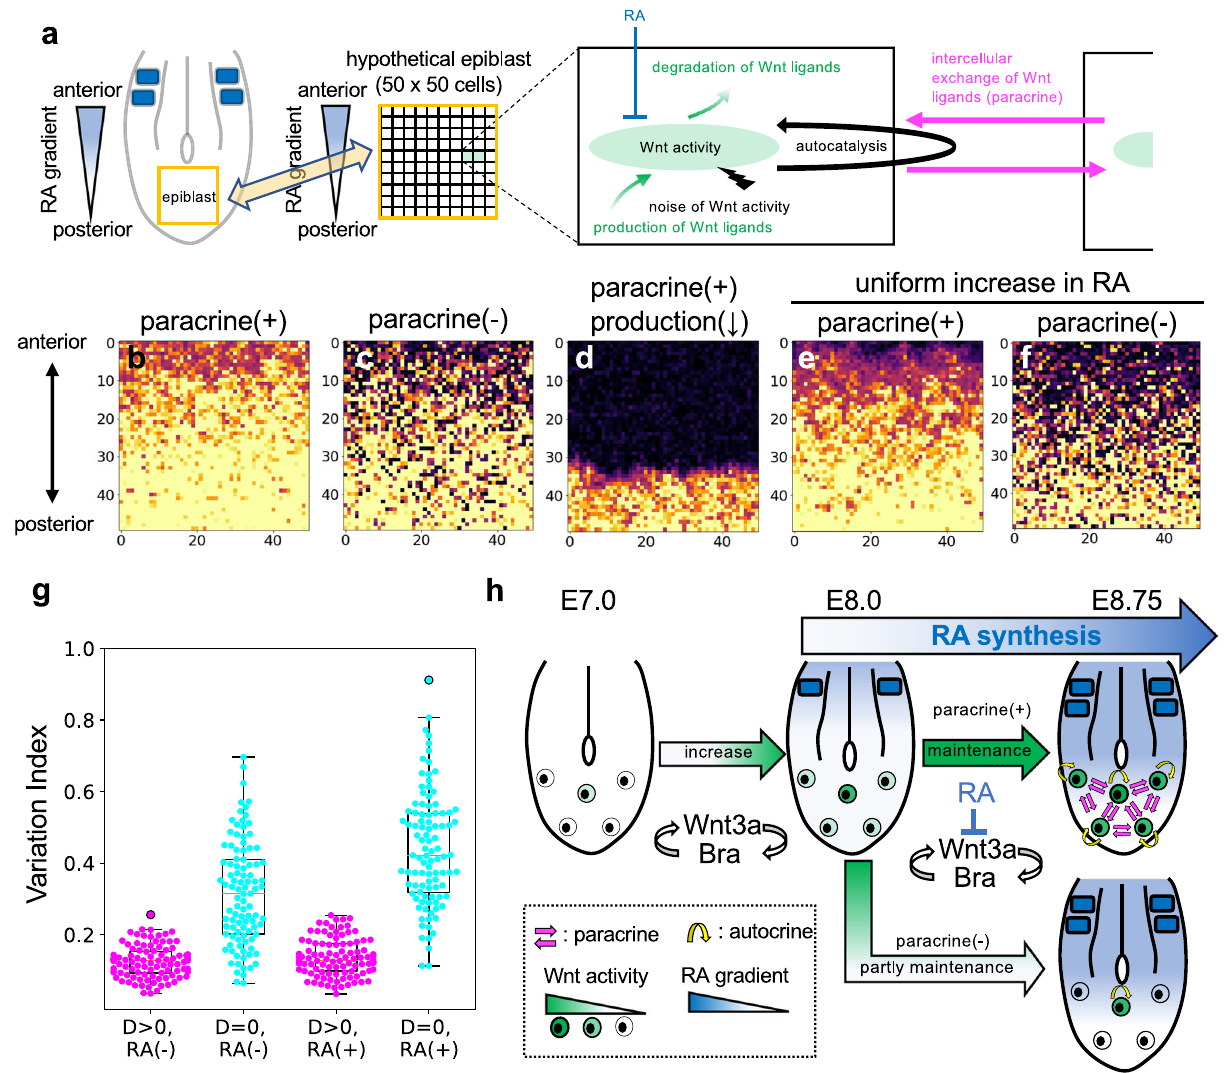
Fig. 7 | Mathematical model to examine the effect of intercellular commu- nicationincellpopulations.a Schematicdiagramshowingparametersusedinthe model. We assumed a virtual space corresponding to the cellsheet of the epiblast. This virtual space is divided into 50 × 50 sections along the antero-posterior and medio-lateral axes. Each section corresponds to a single cell in the epiblast. Wnt activity (W) is determined by parameters such as the rate of production and degradation of Wnt protein, the rate of ampli fi cation or reduction by positive feedback,therateofintercellularexchangeofWntprotein,therateofinhibitionby RA, and fl uctuating noise that affects Wnt activity. It is assumed that cell division occurs randomly and that dividing daughter cells are extruded in one section in eithertheleft,right,oranteriordirectionina1:1:2ratio. b – f SpatialpatternsofWnt activity in a virtual sheet of cells. Examples of the spatial pattern in the presence ( b , d , e ) or absence ( c , f ) of the paracrine function of Wnt are shown at the same